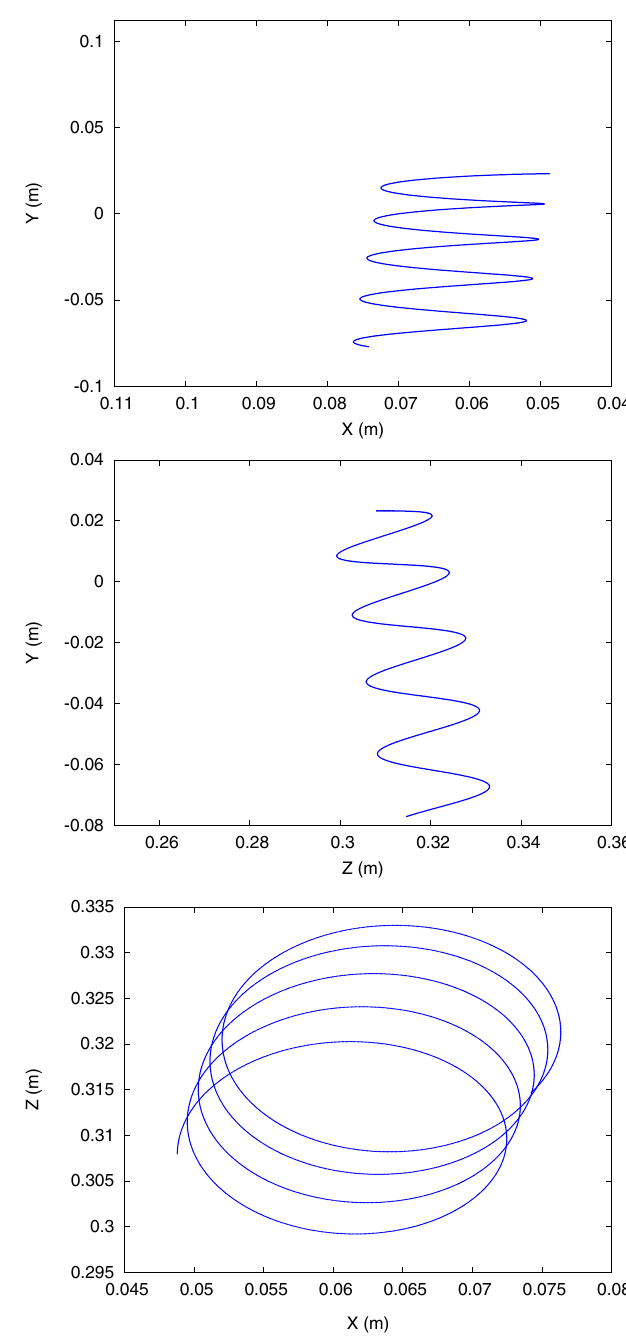
FIG. 10. Example of a typical stripped electron trajectory from the launch coordinate at the foil ( x ¼ 0 : 05 , y ¼ 0 : 025 , z ¼ 0 : 3 ) to the bottom aperture. Three views are shown: X - Y (top), Z - Y (middle), and X - Z